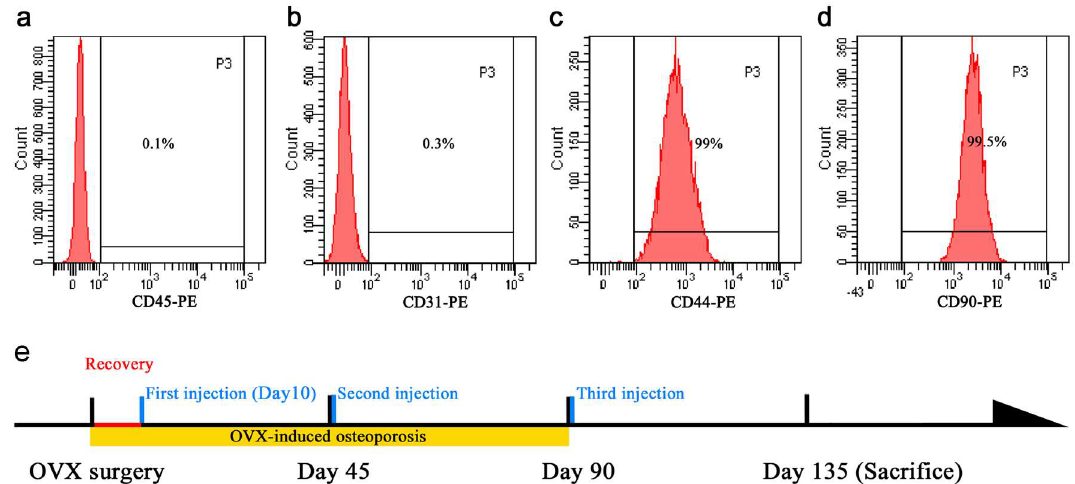
Fig 1. Immunophenotypic characterization of rat mesenchymal stem cells and time point setup. Flow cytometry analysis results confirmed that cells were negative for hematopoietic marker CD45 (a); Cells were negative for endothelial cell marker CD31(b); Isolated BM-MSCs were positive for mesenchymal stem cell markers CD44 and CD90 (c&d). (e) Time point setup. The timepoint that we injected GFP-MSCs was illustrated. The first injectionwas set after 10 days following OVX to allow animal recovery from the surgery. Normallythe rat osteoporosis was induced by ovariectomyfor 3 months, therefore the first two MSCs treatments were to investigate effects of injected MSCs during the osteoporosis development period, and the last injectionwas carried out to test effects of allogeneic MSCs after osteoporosis was